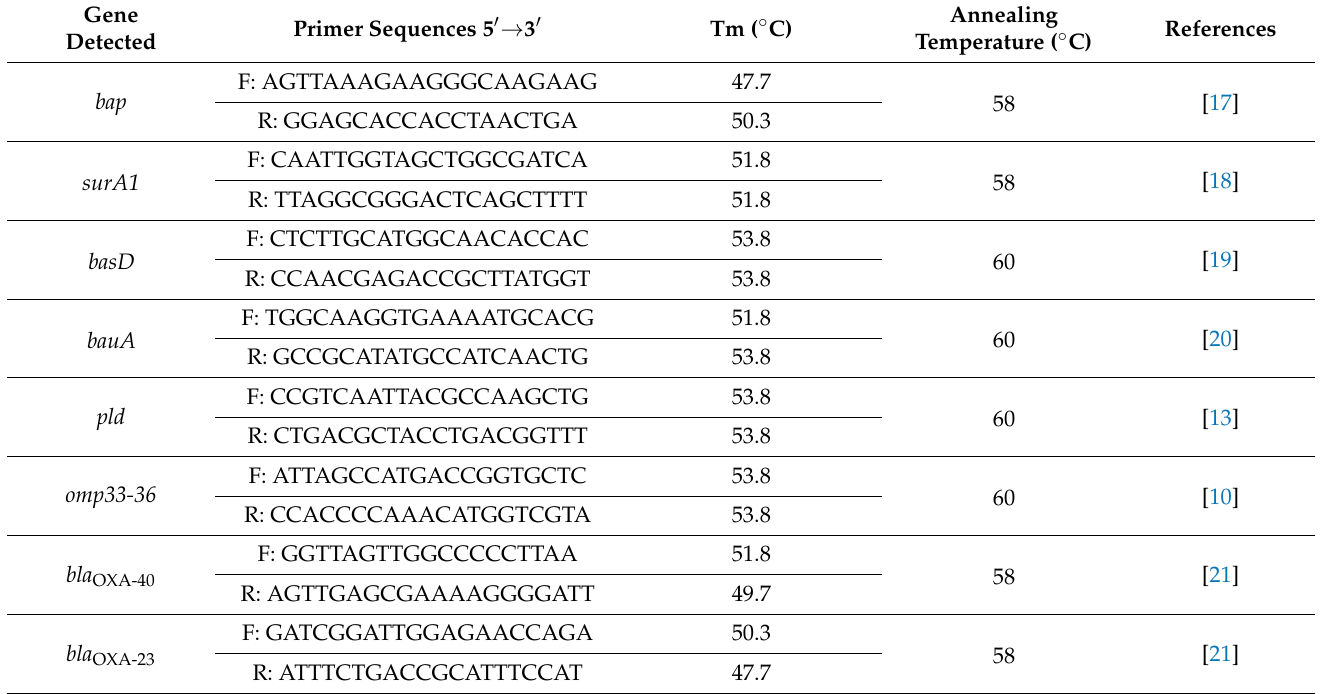
Table 1. Sequences of primers applied for virulence genes detection and real-time PCR parameters used in the study.